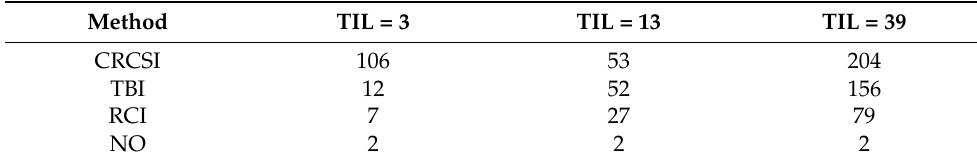
Table 3. Comparison of d min for mobile reception.